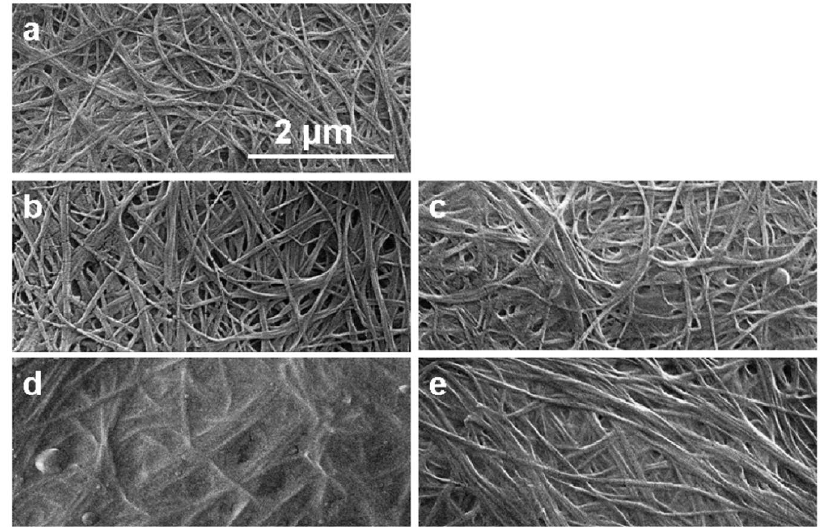
Figure 3. Detailed SEM images: BC ( a ), BC-Ac ( b ), BC-AA ( c ), BC-APS ( d ), BC-VS ( e ).